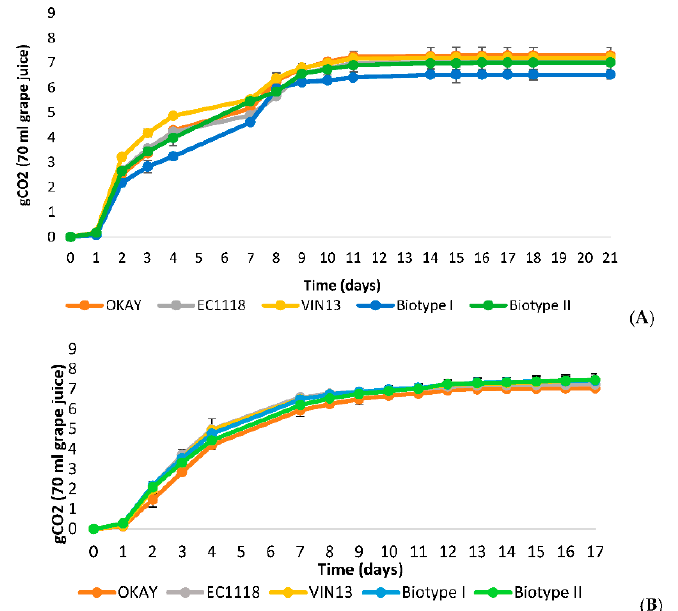
Figure 1. Fermentation kinetic of S. cerevisiae biotypes I and II in comparison with three commercial starters. ( A ) Fermentation carried out at 16 °C. ( B ) Fermentation carried out at 22 °C. Table 3. Main analytical characteristics of wines obtained by the two dominant biotypes compared with commercial starter strains, fermented at 16 ◦ C. Data are means ± standard deviations, and those with different superscript letters ( a–e ) within each column are significantly different, according to Duncan’s test ( p -value <